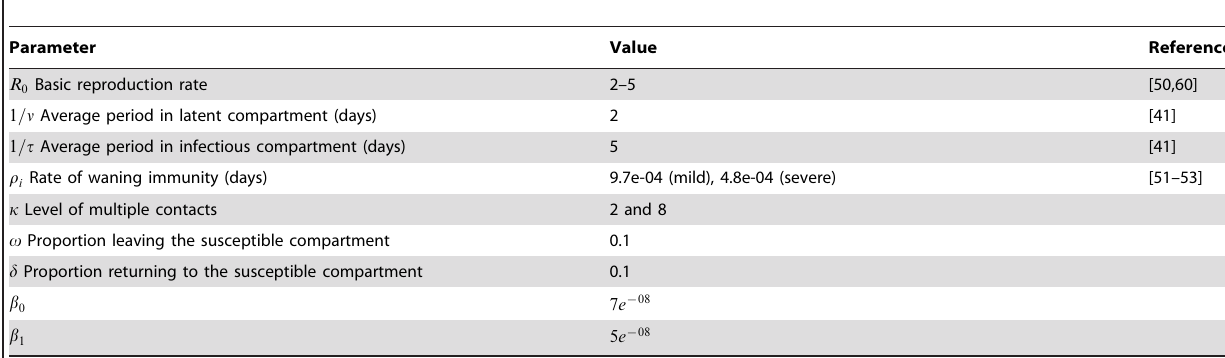
Table 1. Parameters used in the